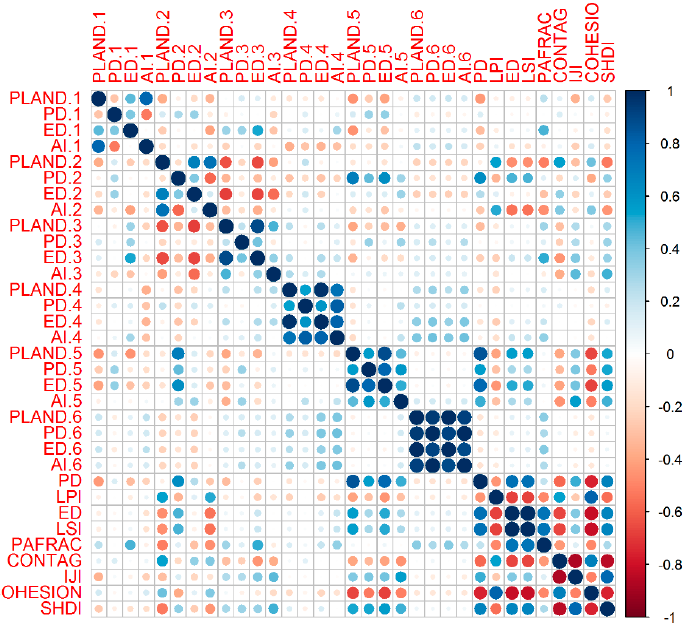
Figure 7. Correlation of the landscape metrics used in the Pearson correlation. Note: metric value at class-level category 1 (crop land), 2 (forest), 3 (grass), 4 (water), 5 (built-up land), 6 (bare land). Table 3. Summary of the partial least squares regression (PLSR) models for specific water contaminants during the dry season.